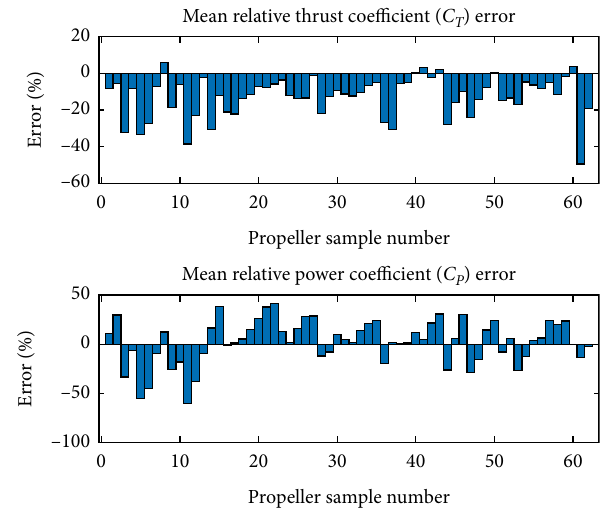
Figure 9: Relative errors between measured and simulated propeller